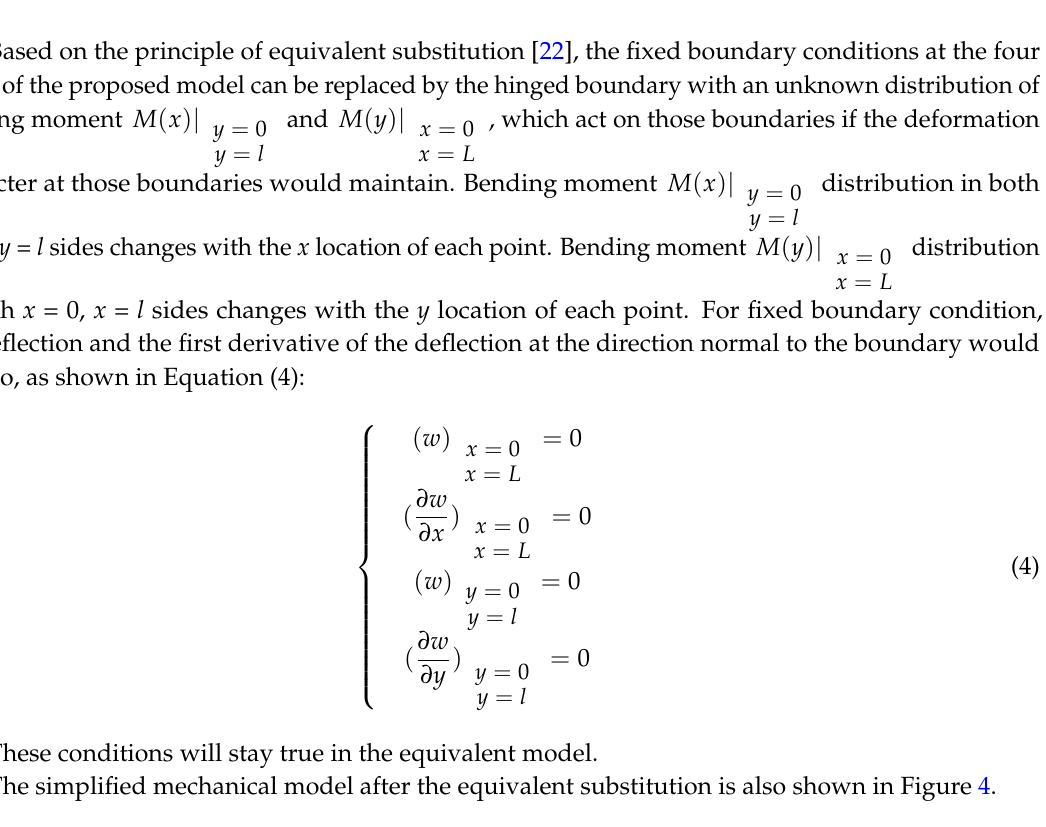
Figure 4. Simplified elastic-thin-plate mechanical model of main roof.